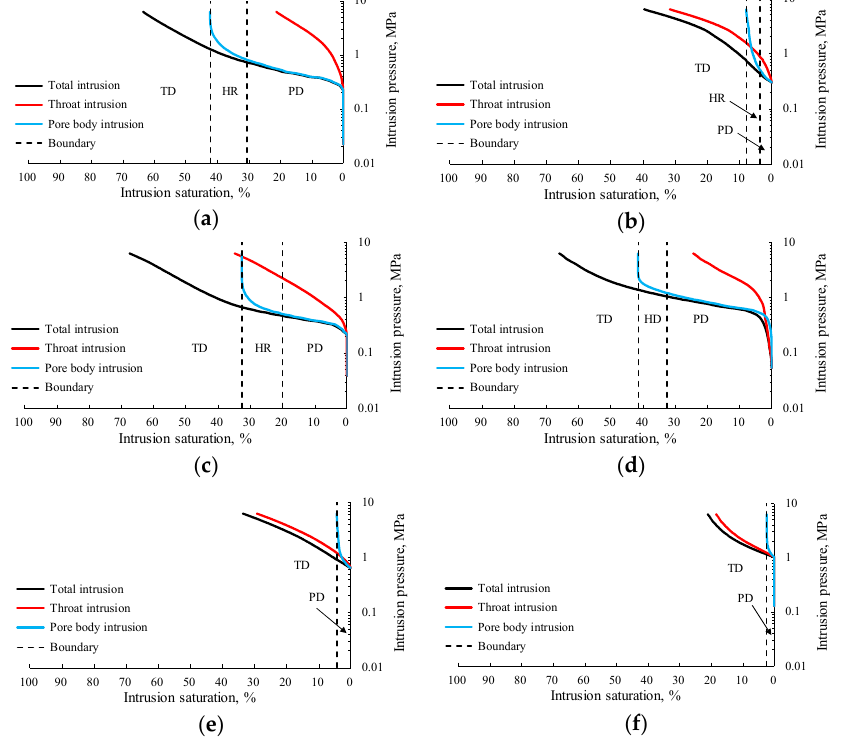
Figure 6. Capillary pressure curves measured by RCMI of typical tight sandstones specimens. ( a ) 11#; ( b ) 5#; ( c ) 14#; ( d ) 12#; ( e ) 4#; ( f ) 8#. PD — pore-dominated region; HR — hybrid region; TD — throat-dominated region.